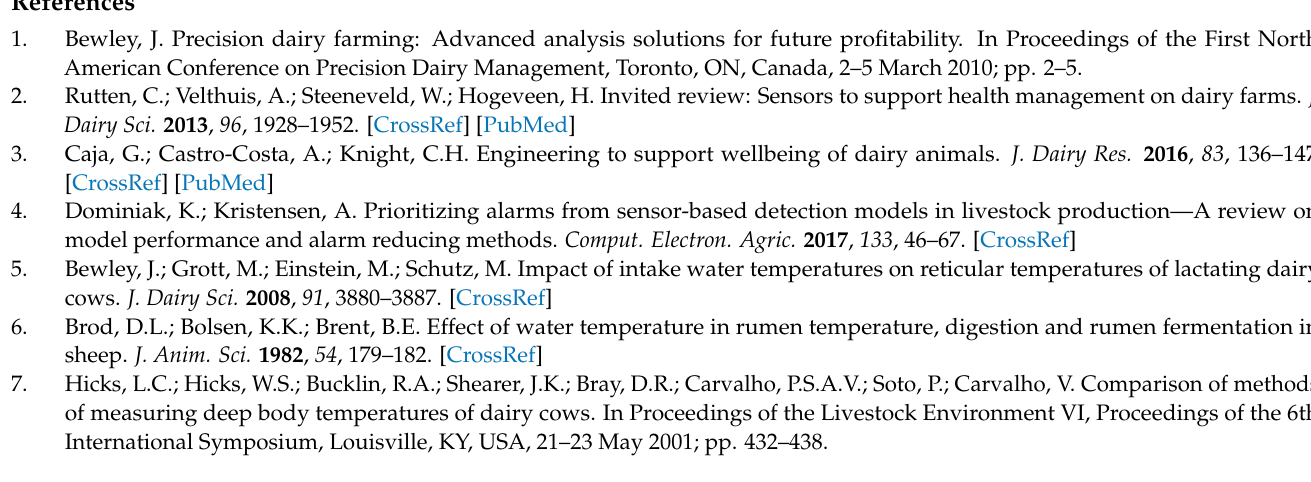
variables generated by the sensors, Table S7: Evaluation results (correlation) for lying time (time spent lying) among activity behavior variables generated by the sensors, Table S8: Evaluation results (performance) for lying time (time spent lying) among activity behavior variables generated by the sensors, Table S9: Evaluation results (correlation) for standing time (time spent standing) among activity behavior variables generated by the sensors, Table S10: Evaluation results (performance) for standing time (time spent standing) among activity behavior variables generated by the sensors, Table S11: Evaluation results (correlation) for walking time (time spent walking) among activity behavior variables generated by the sensors, Table S12: Evaluation results (performance) for walking time (time spent walking) among activity behavior variables generated by the sensors, Table S13: Evaluation results (correlation) for step counts (the number of steps) among activity behavior vari- ables generated by the sensors, Table S14: Evaluation results (correlation) for active time (time spent activity) among activity behavior variables generated by the sensors, Table S15: Evaluation results (performance) for active time (time spent activity) among activity behavior variables generated by the sensors, Table S16: Evaluation results (correlation) for inactive time (time spent inactivity) among activity behavior variables generated by the sensors, Table S17: Evaluation results (performance) for inactive time (time spent inactivity) among activity behavior variables generated by the sensors, Table S18: Evaluation results (correlation) for rumen pH and rumen temperature generated by the reticulo-rumen bolus